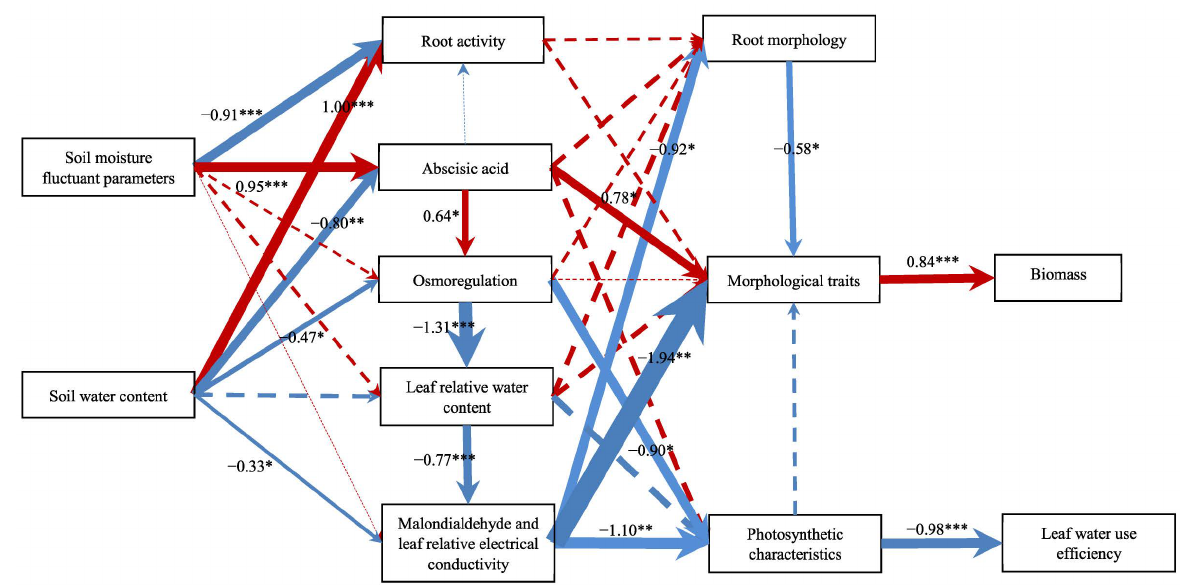
Figure 8. Partial least squares path model (PLS-PM). The path coefficients are represented by the width of the arrows. The red color indicates a positive effect, the blue color indicates a negative effect, the solid arrows indicate significant effects (*, p < 0.05; **, p < 0.01; ***, p < 0.001), and the dashed arrows indicate nonsignificant path coefficients ( p > 0.05). A goodness-of-fit (GOF) statistical evaluation model was used, and the GOF of this model was 0.89. The data used in the PLS-PM were the data from 21 days after treatment.